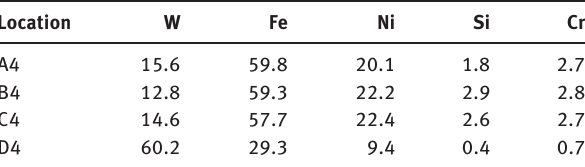
Table 5: EDS results of locations shown in Figure